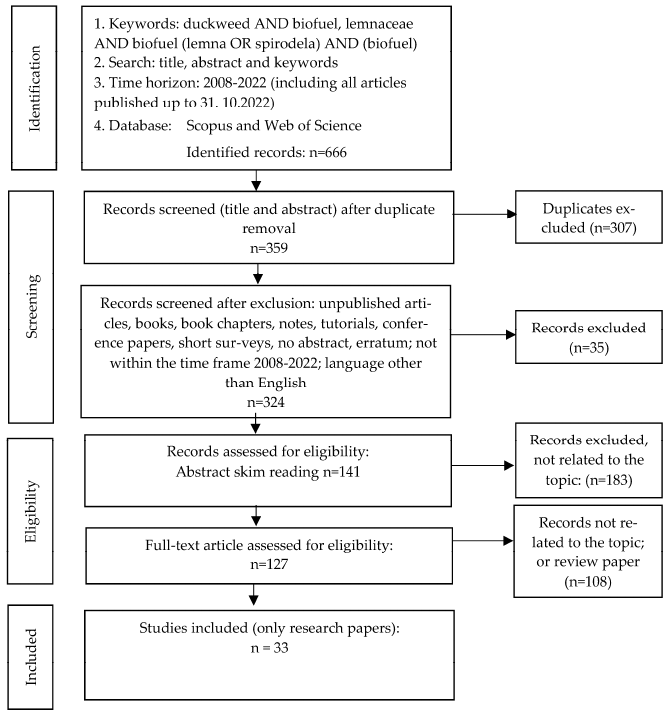
Figure 1. The methodology of the literature review.